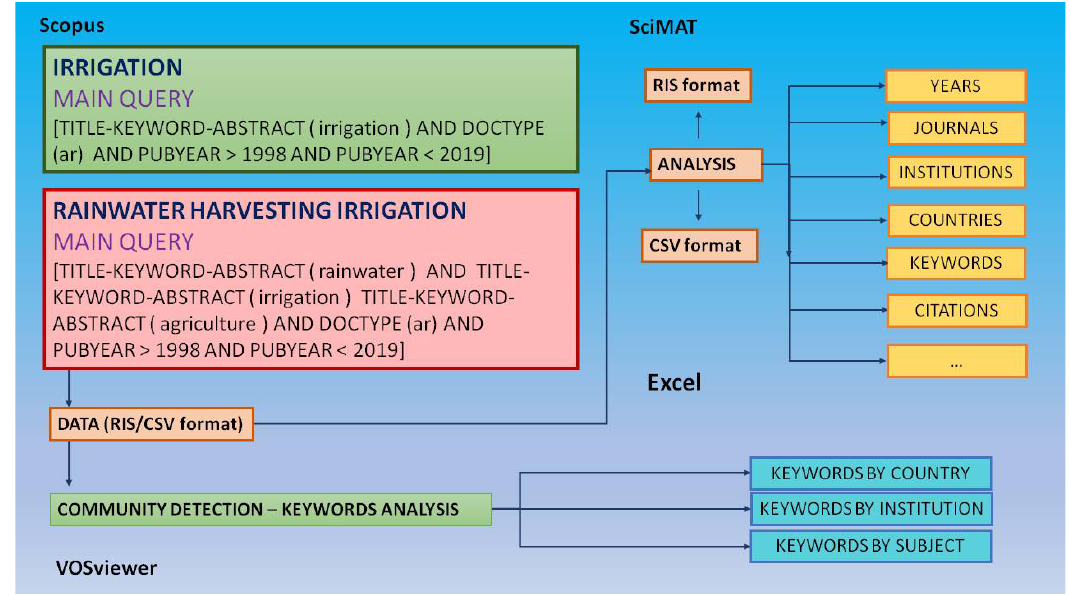
Figure 1. Summary of the methodology.